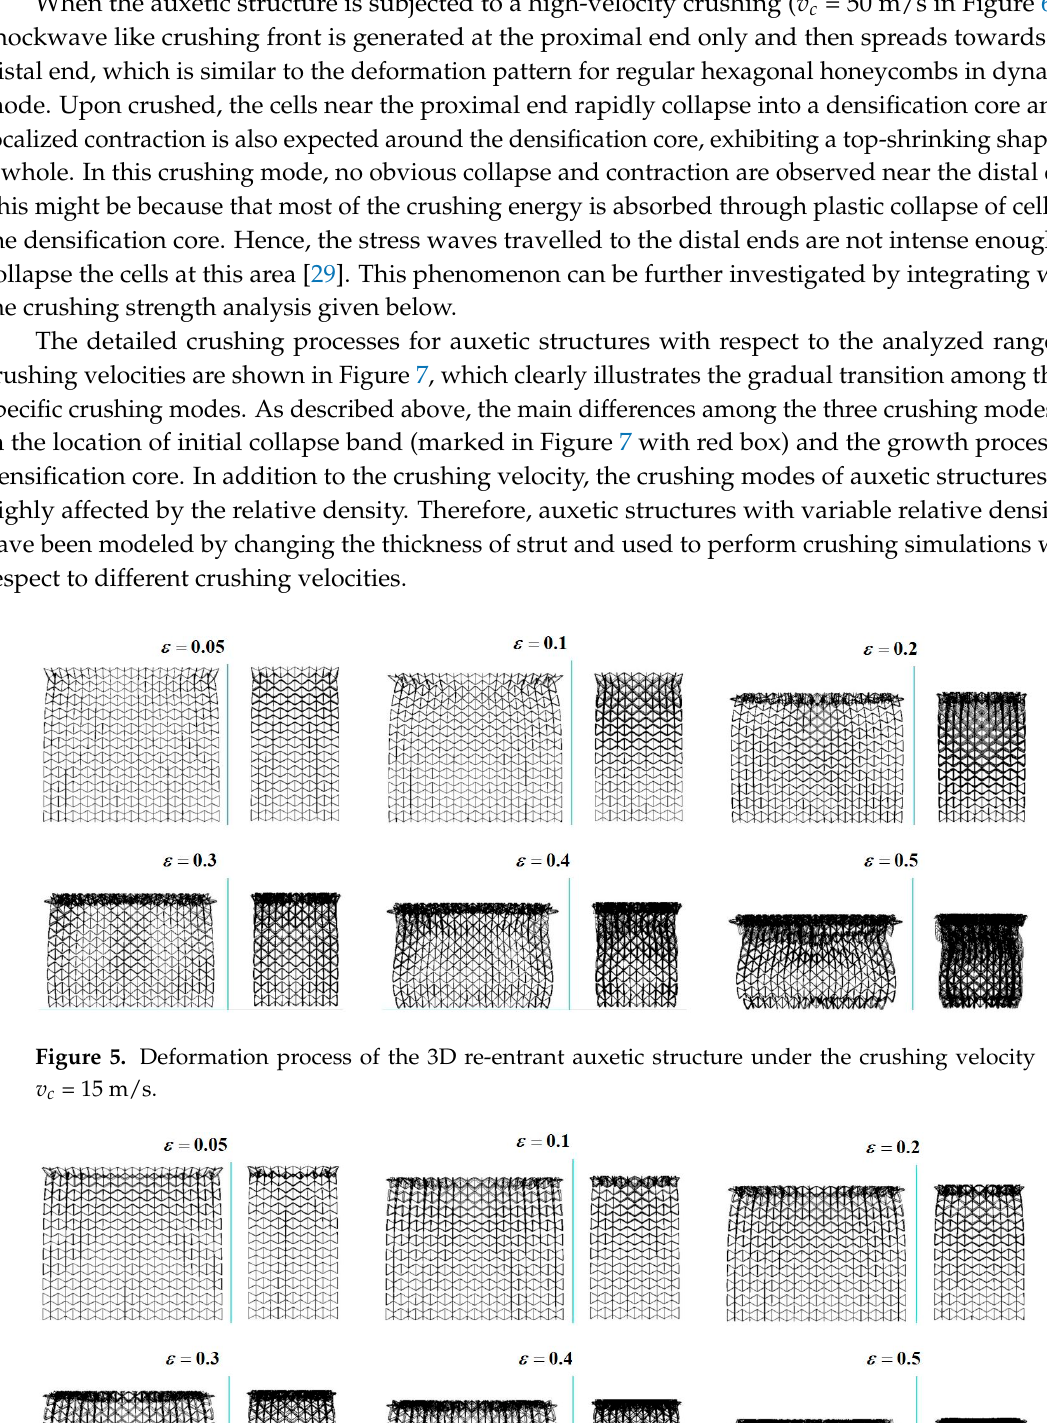
Figure 6. Deformation process of the 3D re-entrant auxetic structure under the crushing velocity 𝑣 (cid:3030) = 50 m/s. The detailed crushing processes for auxetic structures with respect to the analyzed range of crushing velocities are shown in Figure 7, which clearly illustrates the gradual transition among three specific crushing modes. As described above, the main differences among the three crushing modes lie in the location of initial collapse band (marked in Figure 7 with red box) and the growth process of densification core. In addition to the crushing velocity, the crushing modes of auxetic structures are highly affected by the relative density. Therefore, auxetic structures with variable relative densities have been modeled by changing the thickness of strut and used to perform crushing simulations with respect to different crushing velocities.